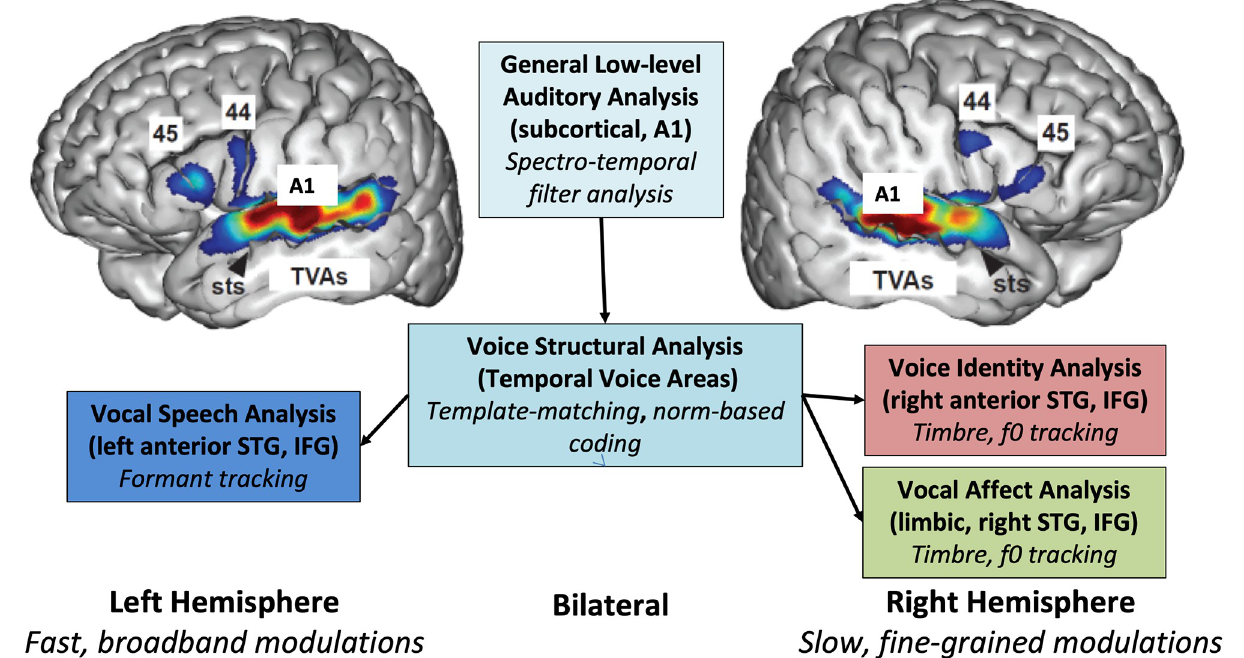
Fig 1. The functional processing hierarchy of auditory communicative signals. TVAs are highlighted. They are the critical intermediate processing stage between general auditory analyses and hemispherically lateralized processes dedicated to socially relevant auditory signals. IFG, inferior frontal gyrus; STG, superior temporal gyrus; STS, superior temporal sulcus; TVA, temporal voice